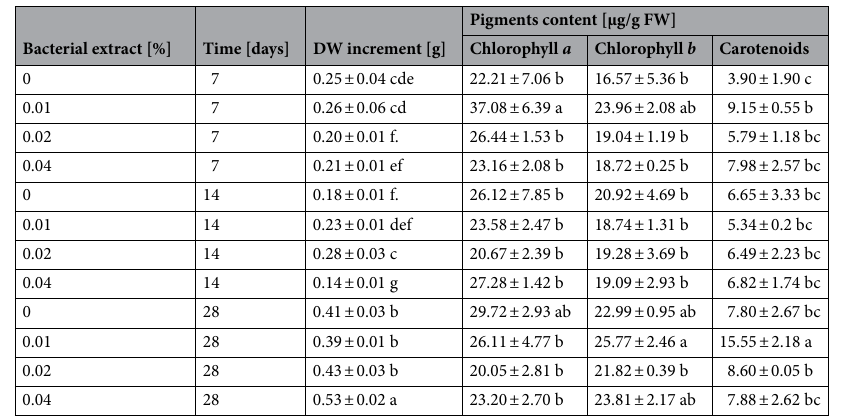
Table 2. Effect of Paenibacillus lautus strain PLV elicitation on dry biomass increments and pigments content in L. aestivum in vitro plants. The results are means of three replicates (n = 3) ± SD. Different letters indicate a significance difference at P < 0.05 according to ANOVA and Duncan’s test; DW: dry weight, FW: fresh